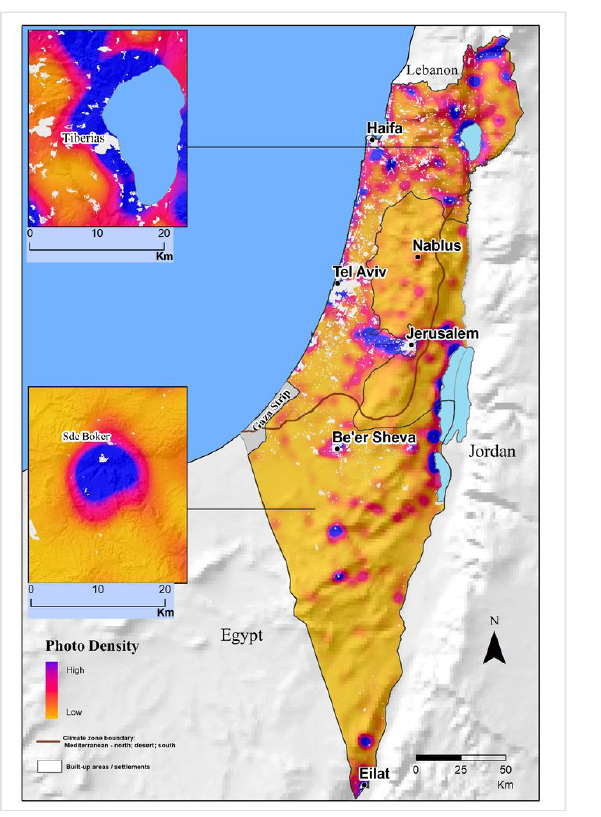
Density of geotagged photo taken from Panoramio website (2005-2016). Mapping was done using kernel function with a search radius of 5 km and a resolution of 100